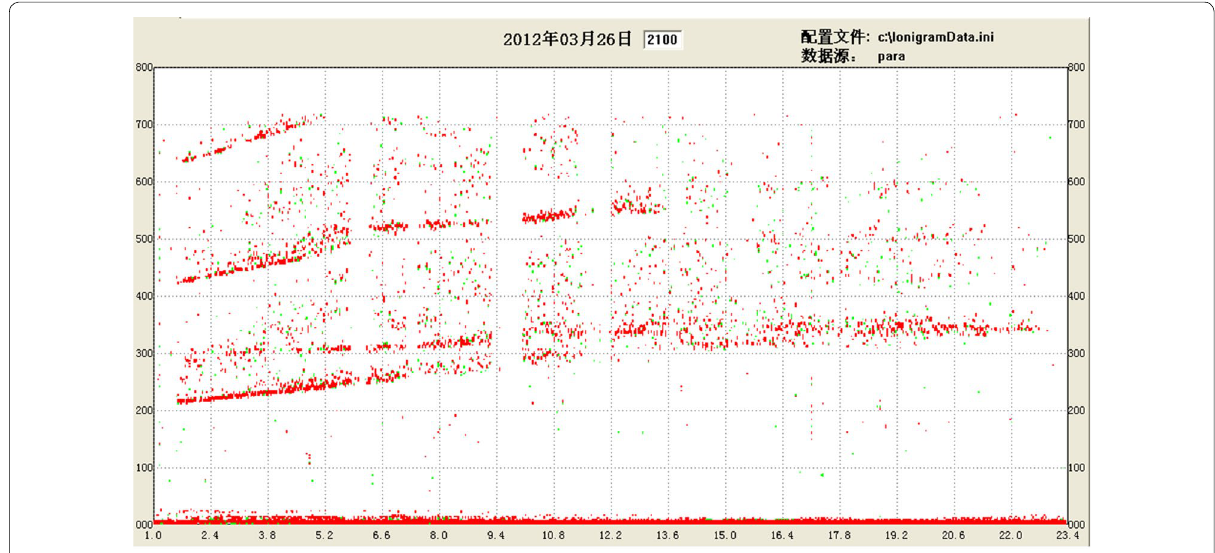
Fig. 3 A SSF event in Haikou on March 26,